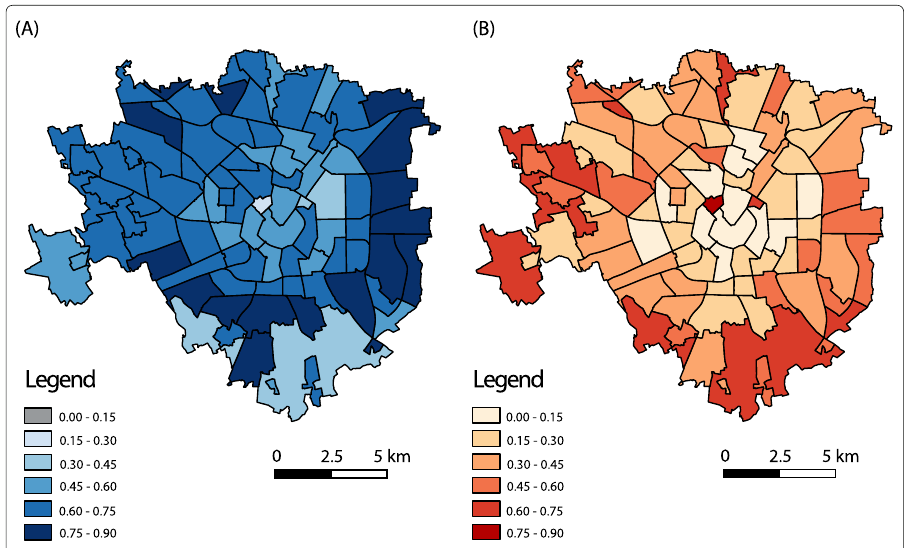
Fig. 2 α - and β -diversity based on land use distribution in Milan. a Map of α -diversity computed with the Simpson index on the basis of land uses; the darker the NILs’ colors, the higher their α -diversities and, thus, their urban richness. b NILs are colored according to the Euclidean distance between their vector of land-use mix and the one of NIL 1, the city